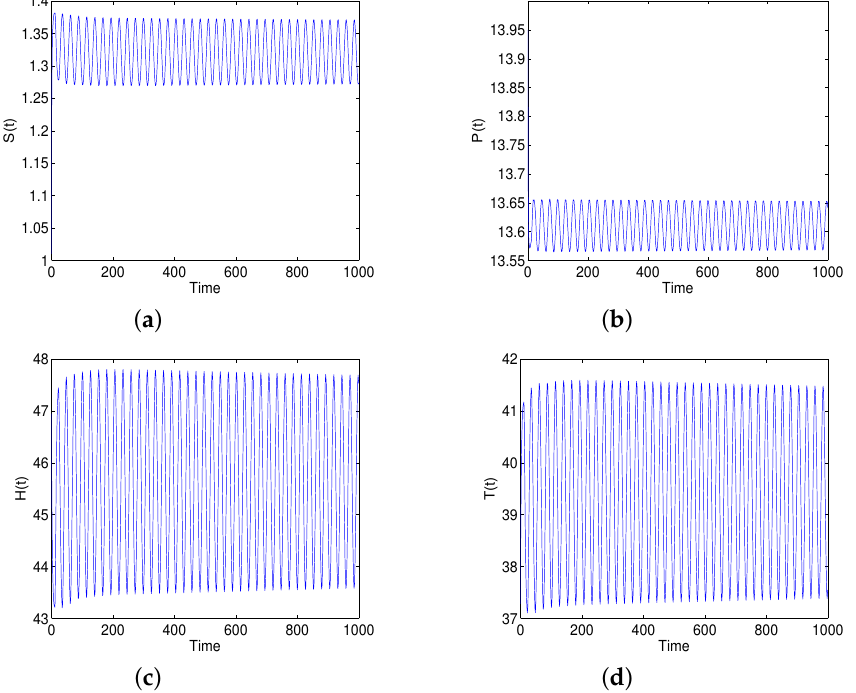
Figure 2. The time plot of ( a ) susceptible population, ( b ) psychological addicts, ( c ) physiological addicts and ( d ) drug-users in treatment for τ 1 = 11.1421 > τ 10 = 9.7367 with A = 2, d = 0.02, β 1 = 0.016, β 2 = 0.028, π = 0.03, γ = 0.095, θ = 0.5 and σ =